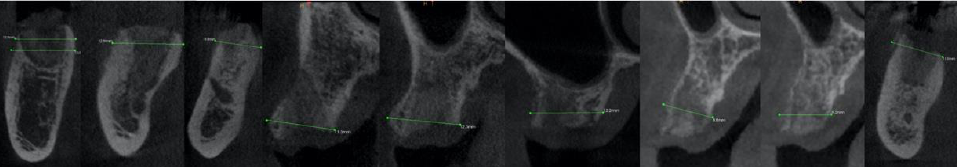
Figure 6. CBCT images of the nine consecutive cases treated with MPI at 4 months of healing.